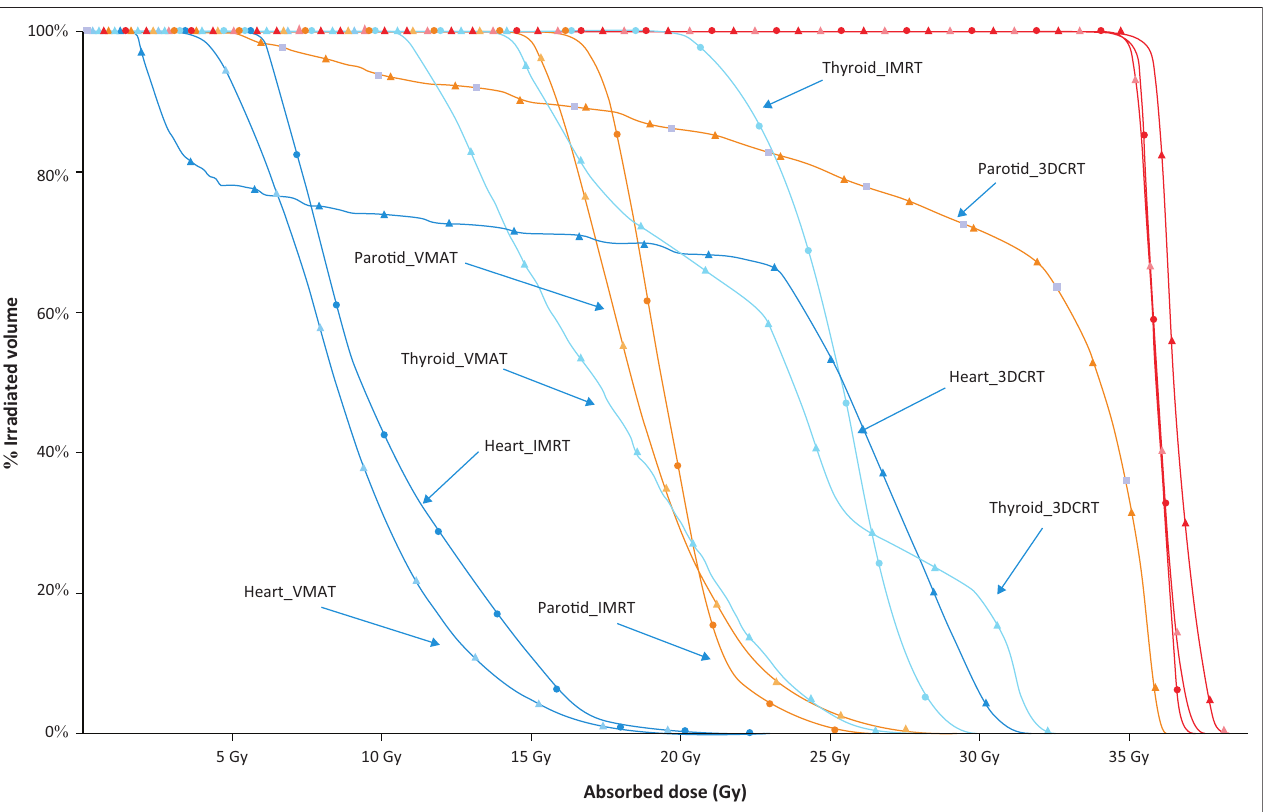
FIGURE 4: Dose-volume histograms for heart, left parotid and thyroid for one